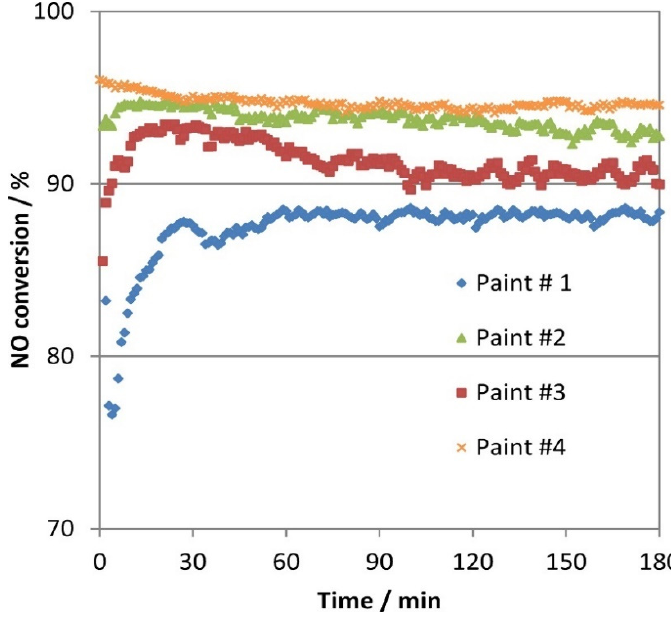
Figure 9. NO conversion for the four tested paints [131] . Paint #1 to Paint #4: Paints formulated with varying compositions of TiO 2 , CaCO 3 , P25, and PC500.